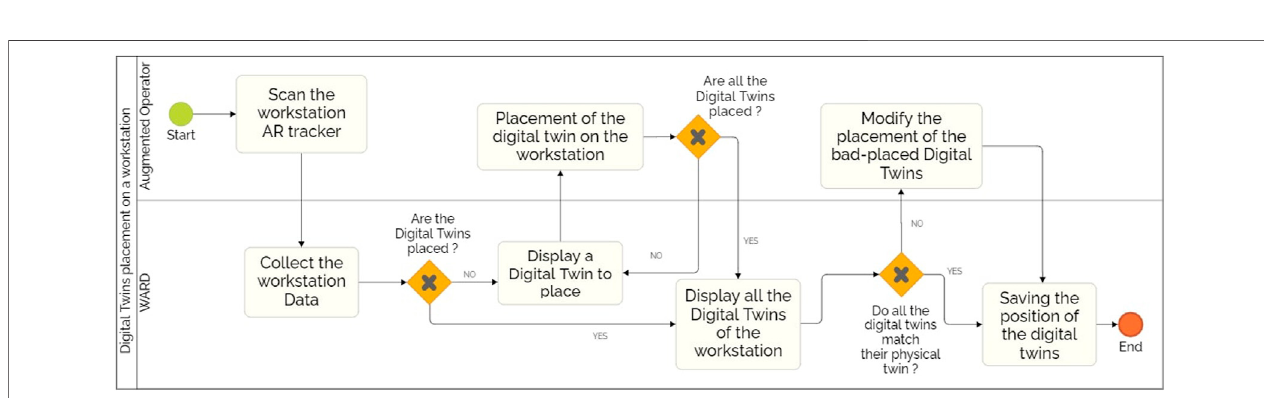
FIGURE 7 | BPMN diagram of the use of WARD to place or update the digital twins of a